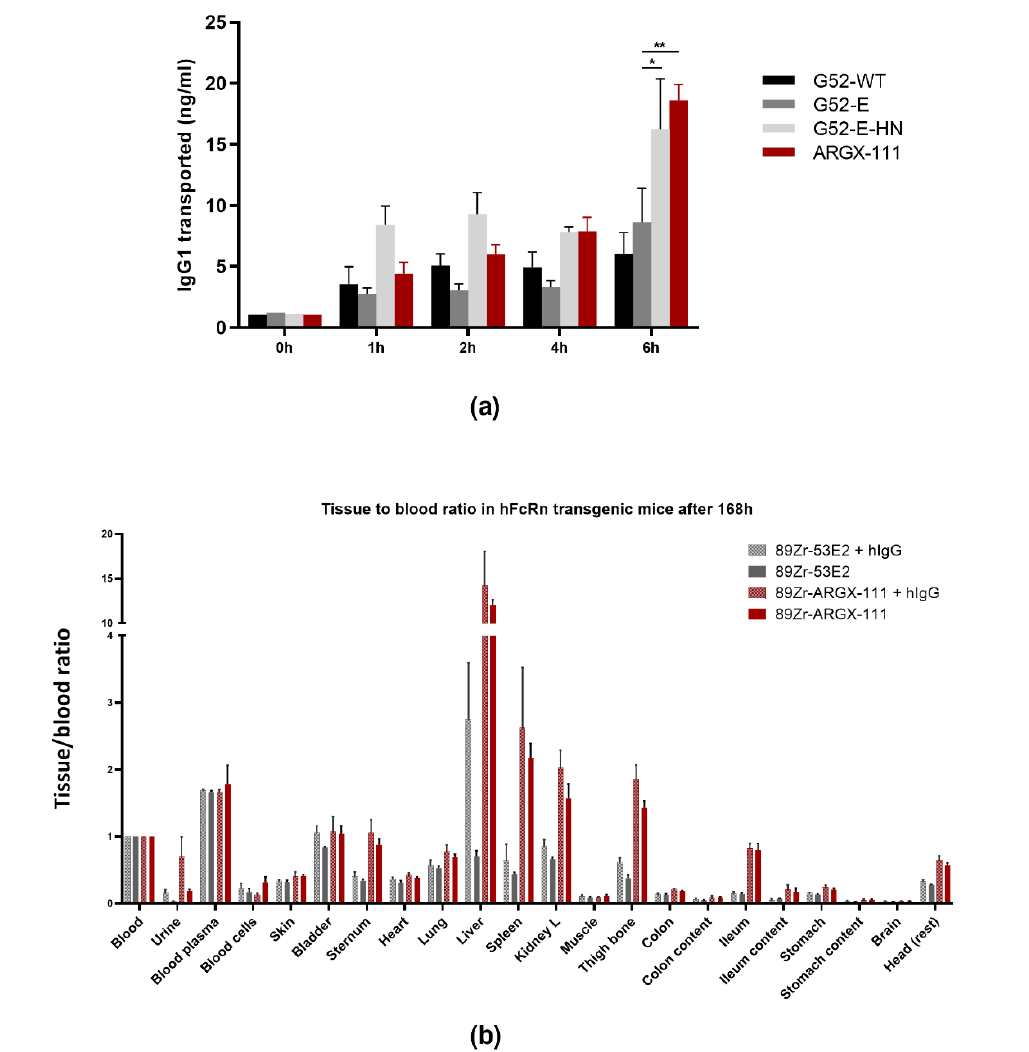
Figure 2. In vitro and in vivo characterization of NHance ® -mutated ARGX-111 for FcRn-mediated transcytosis. ( a ) NHance mutations promote transcytosis across MDCK II cells overexpressing human FcRn. Transwell assay showing apical-to-basolateral transport of Fc-engineered variants of ARGX-111. Measured antibody concentrations in the basolateral compartment are shown in ng/mL; ( b ) Tissue distribution of ARGX-111 in 32TG human FcRn transgenic mice. Tissue/blood ratio in mice (N = 3) analyzed 168 h after administration of 89 Zr-labelled ARGX-111 or 53E2 in the presence of hIgG or not. Bars represent mean ± SEM; * p = 0.0174; ** p = 0.0005.